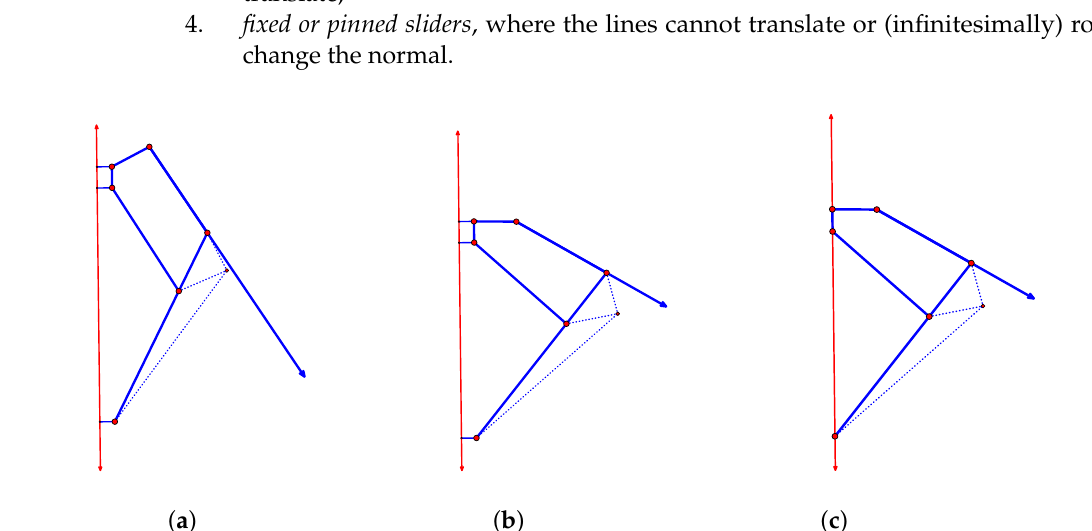
Figure 18. A point-line framework version of the window slider mechanism ( a , b ) showing two positions of a finite motion. In ( c ), the line for the slider is shifted to pass through the vertices as it is in the original mechanism.